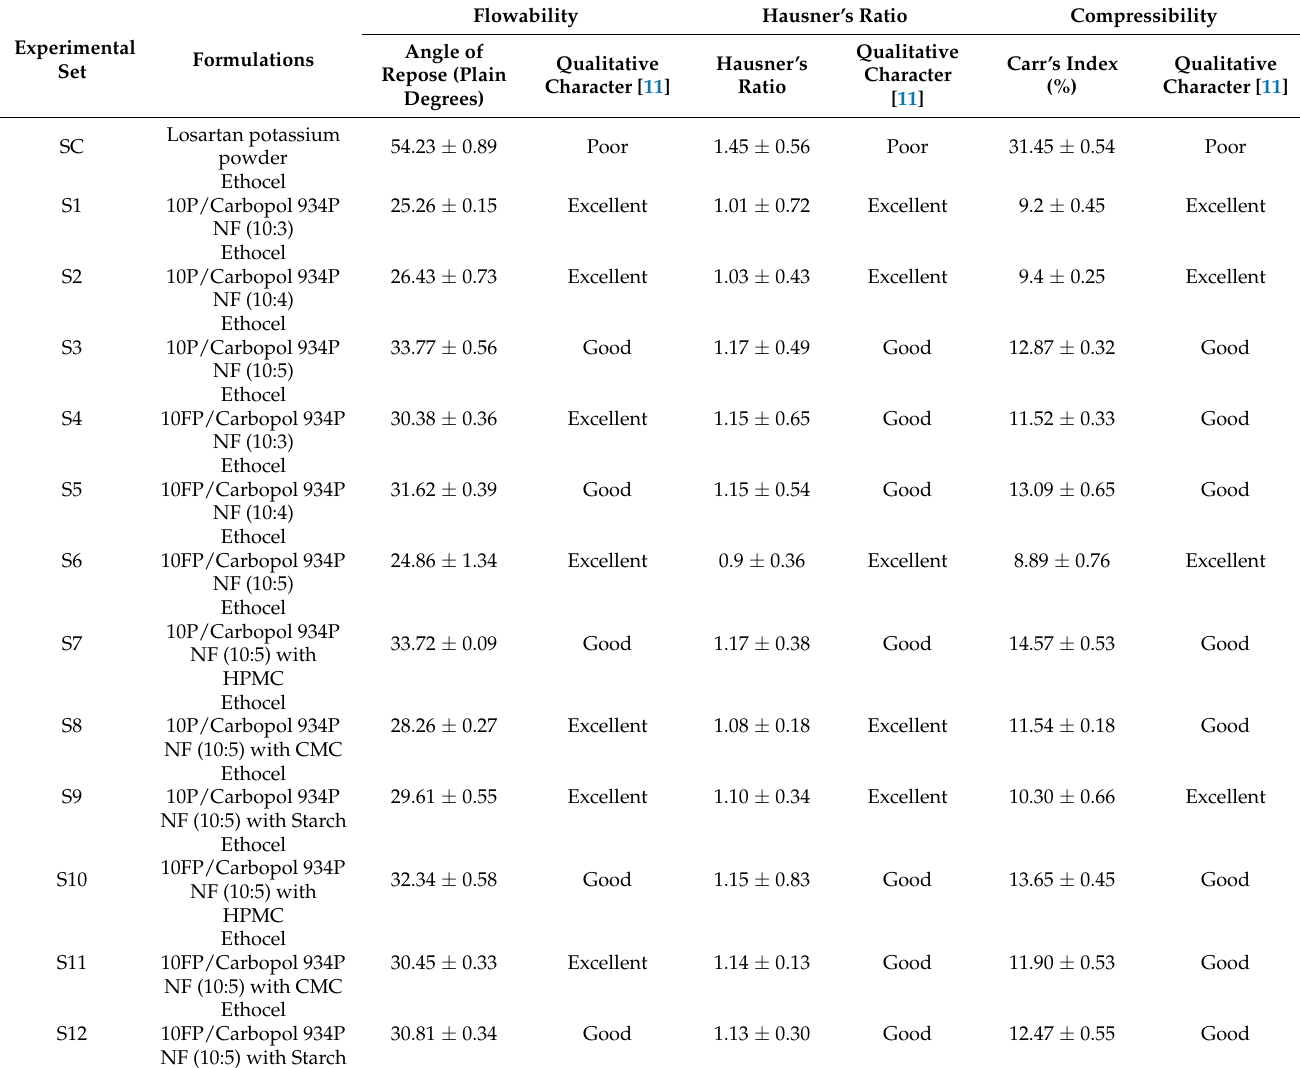
Table 2. Flow properties of the tested